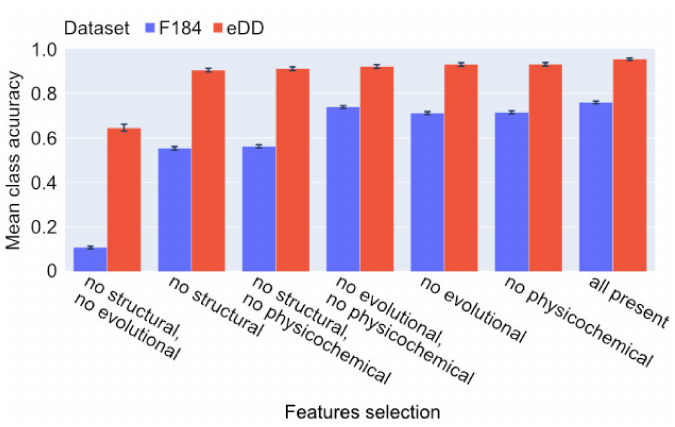
Figure 3. Impact of selected features on test accuracy. The number of points in the input are the same as those from the best full model from the particular dataset (1024 points for each). Mean taken from the last 20 epochs after the model reached a plateau. Whiskers represent standard deviations of test accuracy